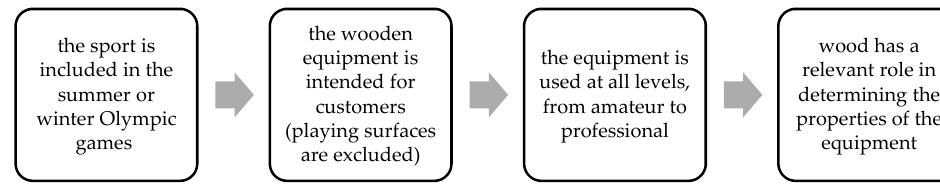
Figure 1. Criteria used for the selection of sports.